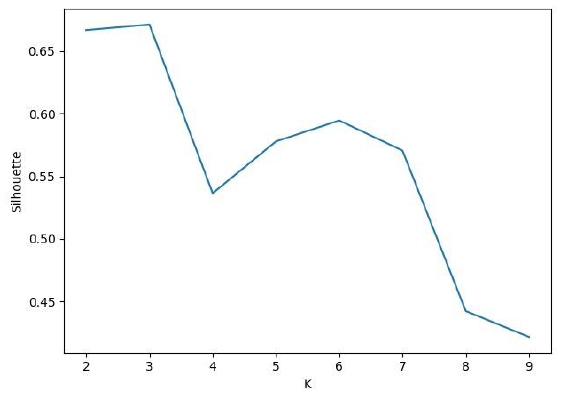
Figure 5. The changes in silhouette values with different numbers of cluster. Silhouette coefficient was calculated by repeating clustering operations, and the larger the silhouette value is, the better the clustering effect will be.